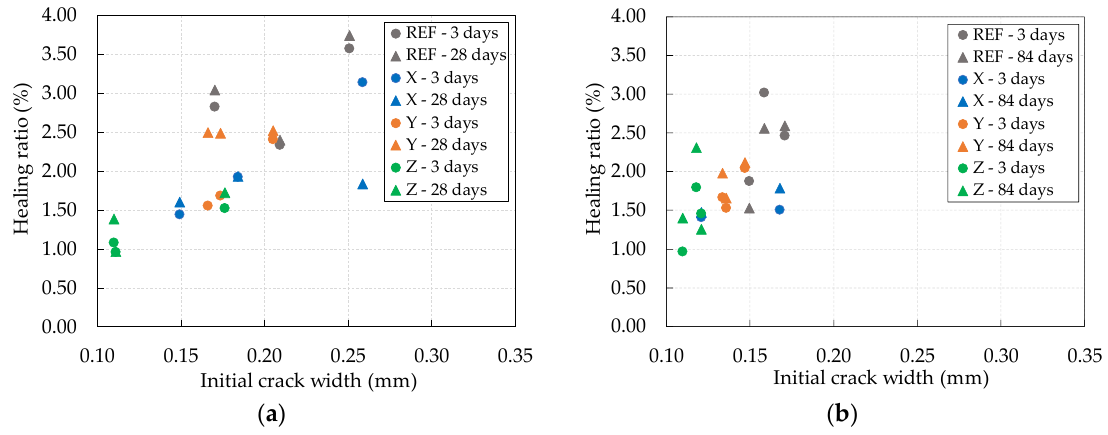
Figure 8. Healing ratio as a percentage versus initial crack width: ( a ) after two wet–dry cycles; ( b ) after six wet–dry cycles.